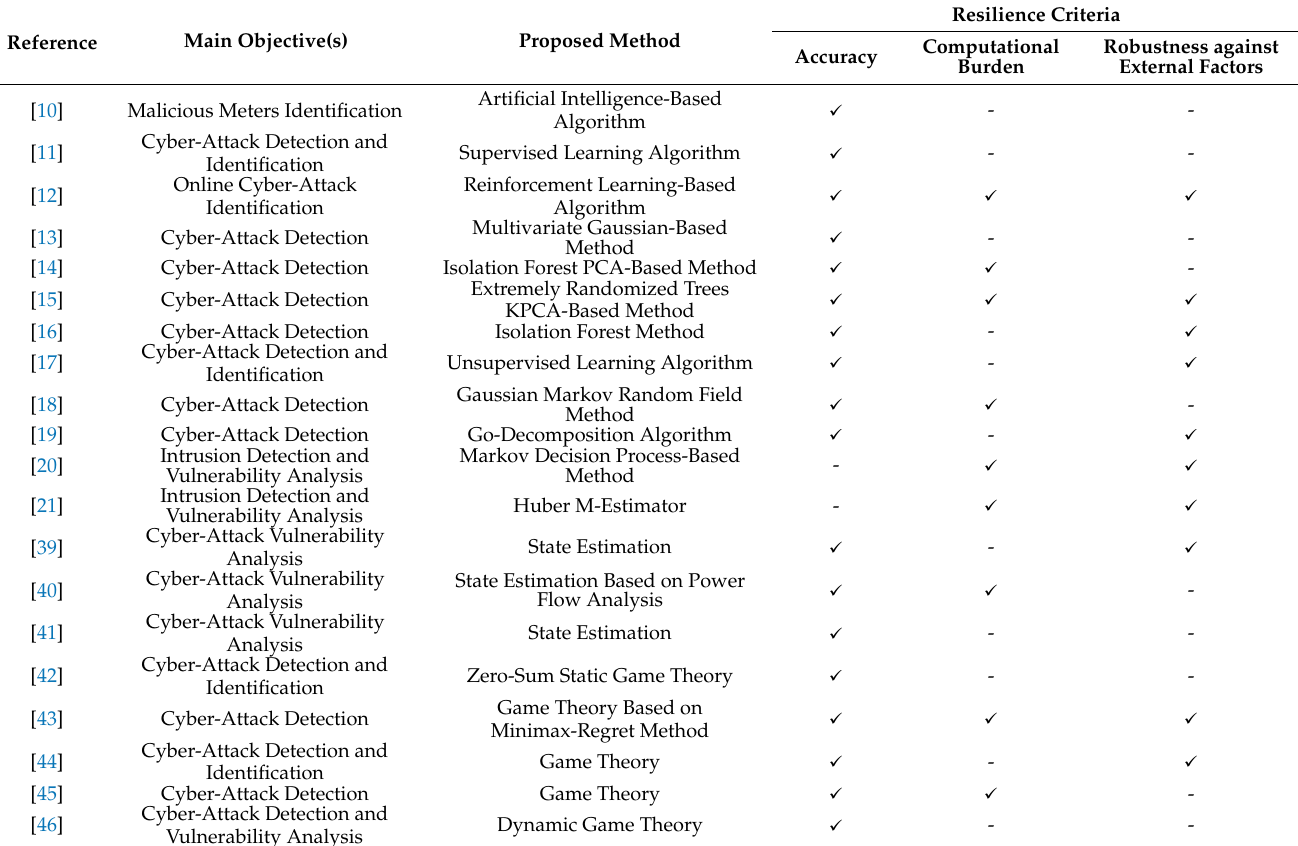
Table 1. Comparison of different cyber-attack detection and identification techniques.